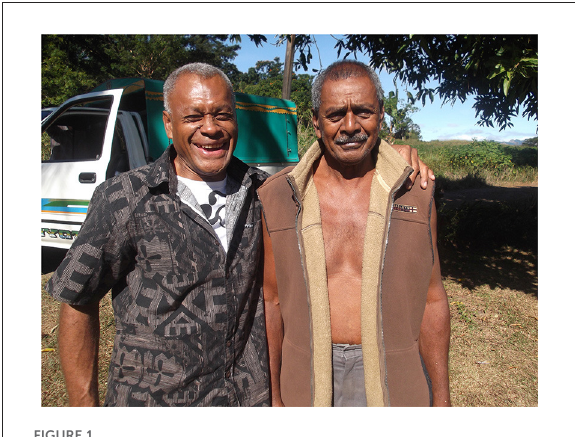
FIGURE1 Henry Dyer (left) with Semi Tabaiwalu, Ba, Fiji, 17 June